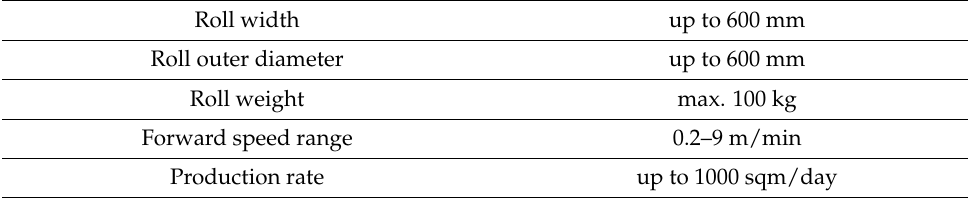
Table 1. Specifications of the R2R pilot line for prepreg production.